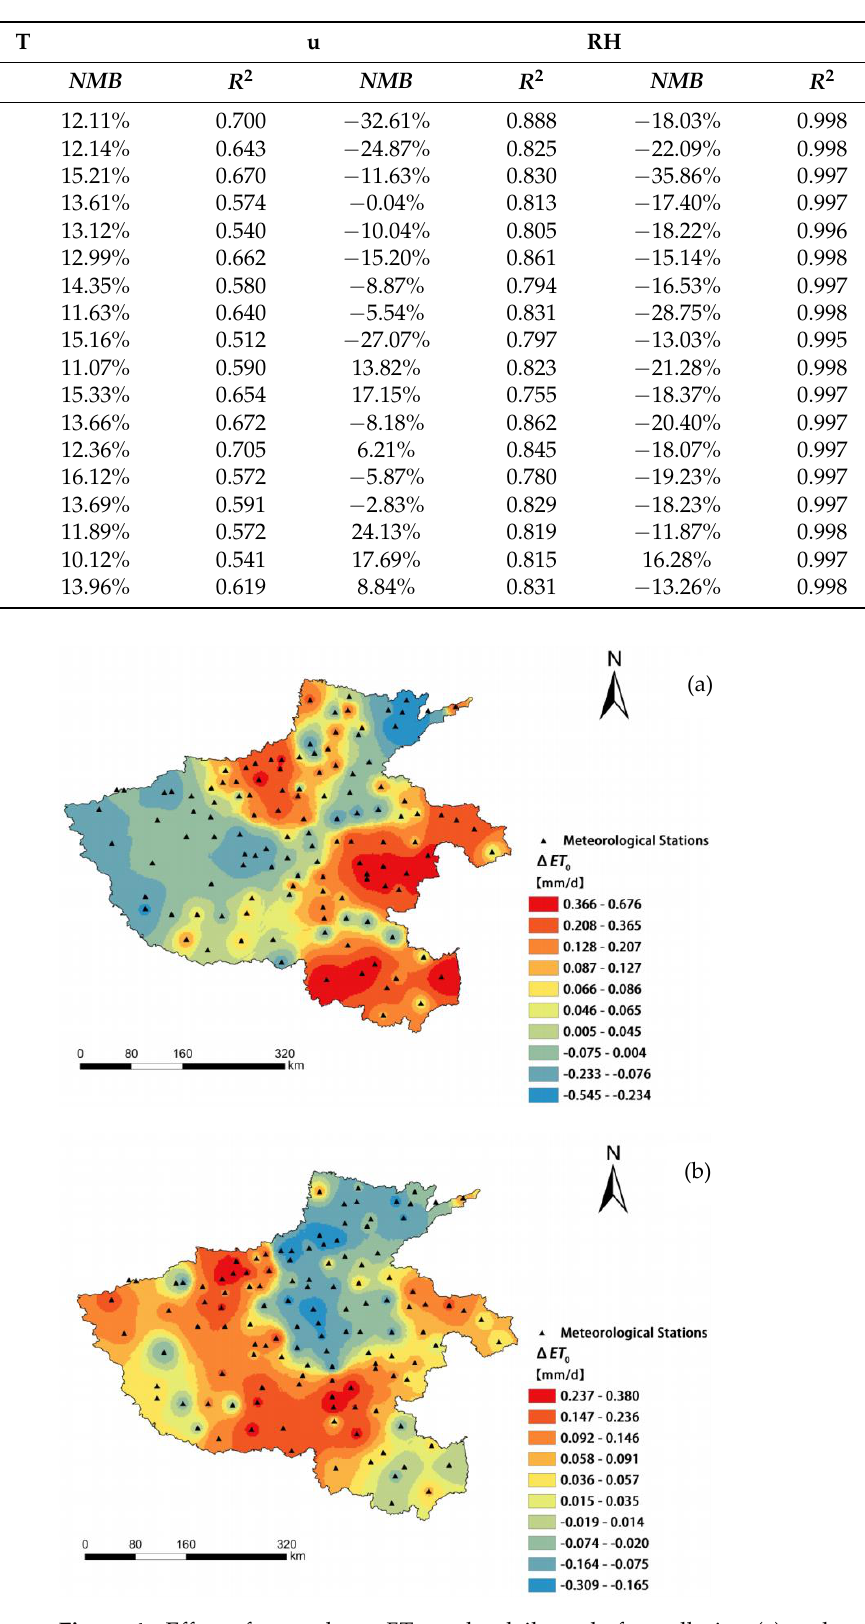
Table 2. Simulation accuracy verification.